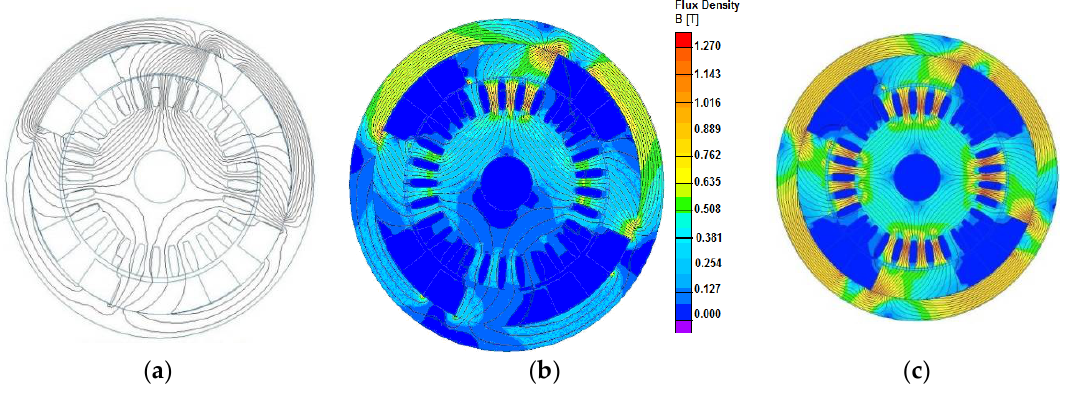
Figure 5. The starter R5 spread of magnetic flux for the gap in a segment of the commutator ( a ); the distribution of magnetic induction for the gap in two segments of the commutator and the worn sleeve ( b ) and efficient starter ( c ).